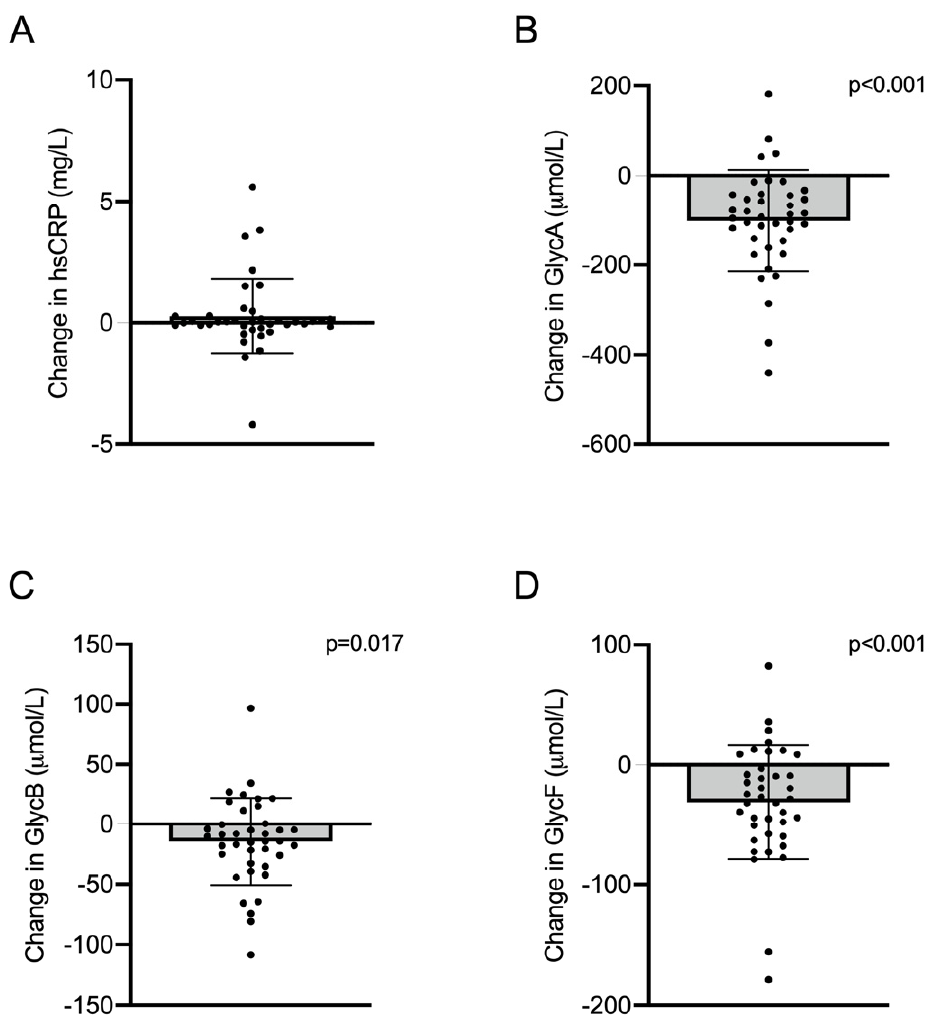
Figure 1. Mean changes in ( A ) high-sensitivity C-reactive protein (hsCRP) and 1H nuclear magnetic resonance (1H-NMR)—assessed glycoproteins ( B ) A, ( C ) B and ( D ) F concentrations after iPCSK9 therapy. Error bars indicate SD.